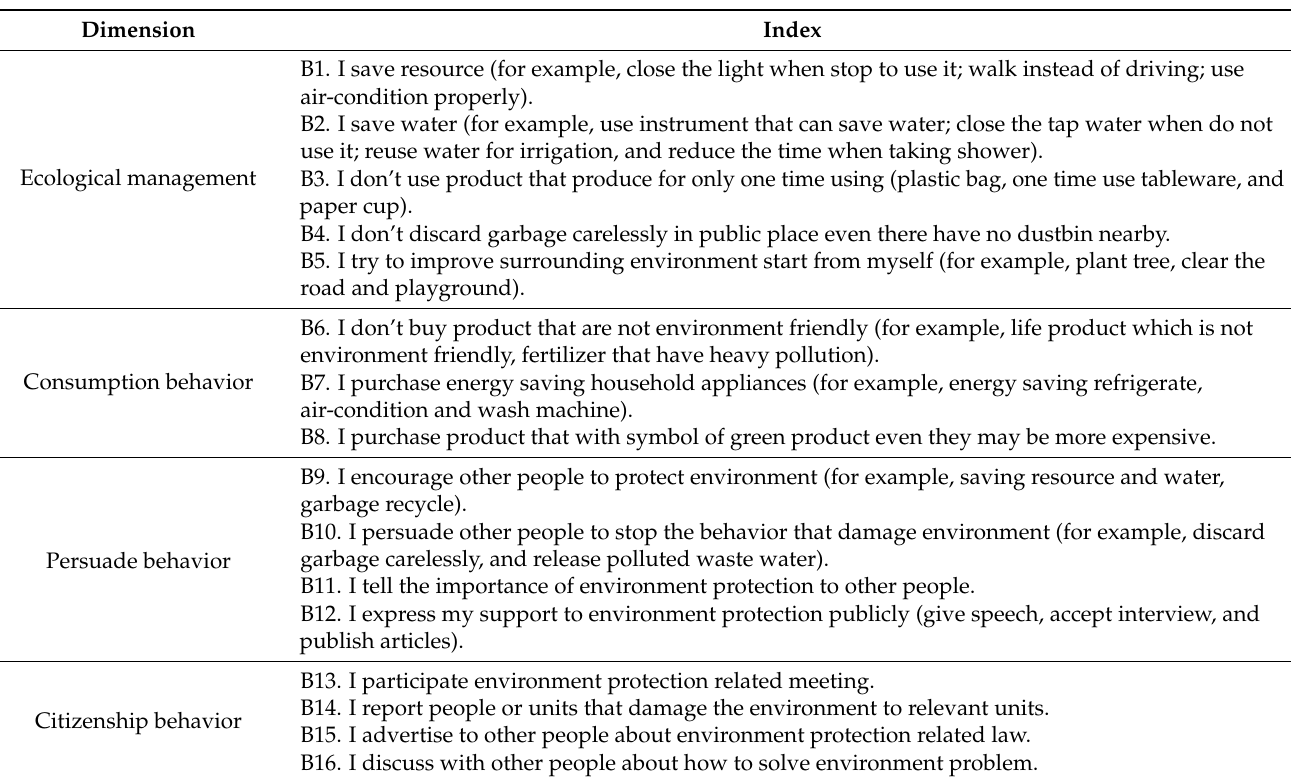
Table 3. Pro-environmental behavior scale